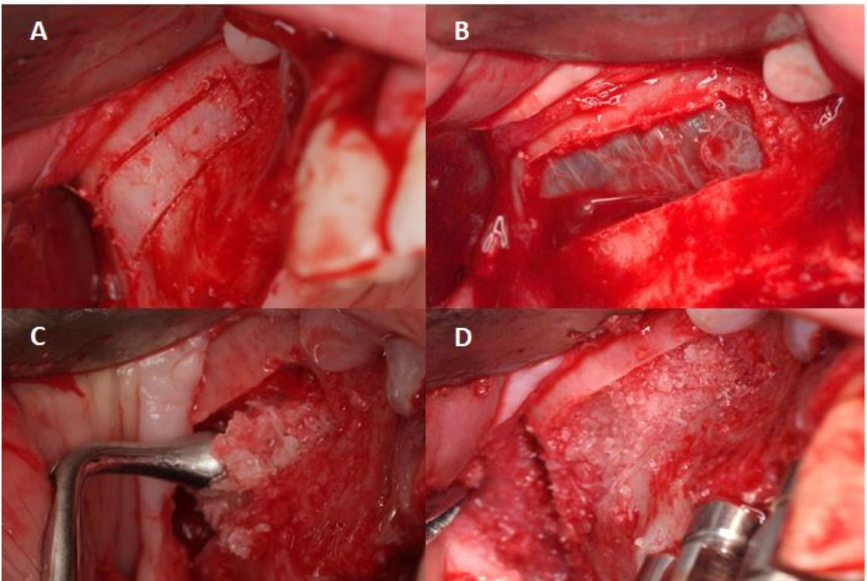
Figure 2. ( A ) Design of the osteotomy using a Piezomed insert of the brand W&H, B1 (REF 05530100); ( B ) design of the lateral window and visualization of the Schneider membrane; ( C , D ) once the Schneider membrane has been detached and raised, the cavity is filled with particles of β -TCP.